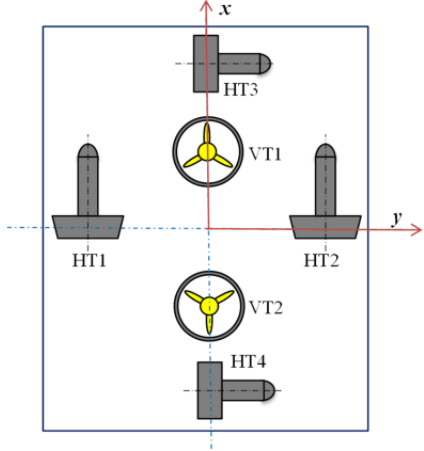
Figure 2. Beaver II thruster layout.